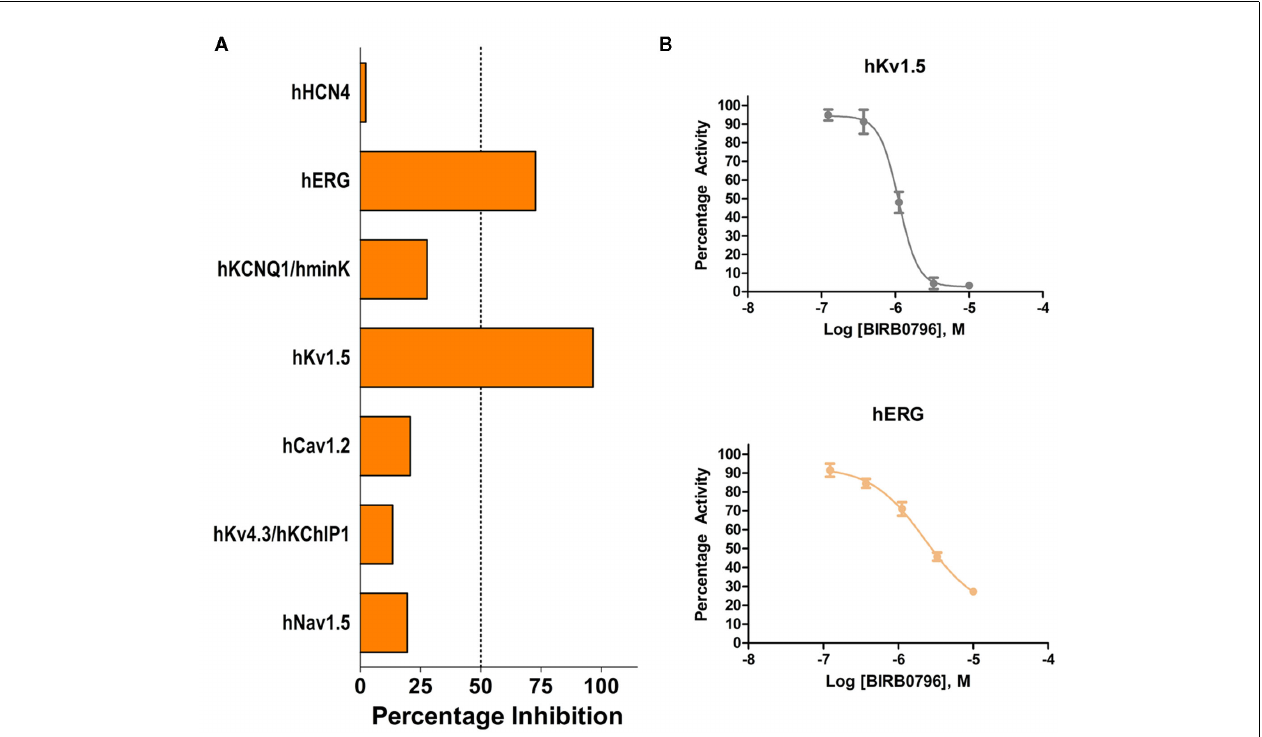
FIGURE 1 | (A) Activity of 10 μ M BIRB0796 on cardiac ion channels within Millipore’s Safety and Liability Panel. (B) Because of the significant inhibition observed at 10 μ M, full concentration response curves for hERG and Kv1.5 were carried out with BIRB0796. Calculated IC 50 values were 2.3 and 1.1 μ M for hERG and Kv1.5,